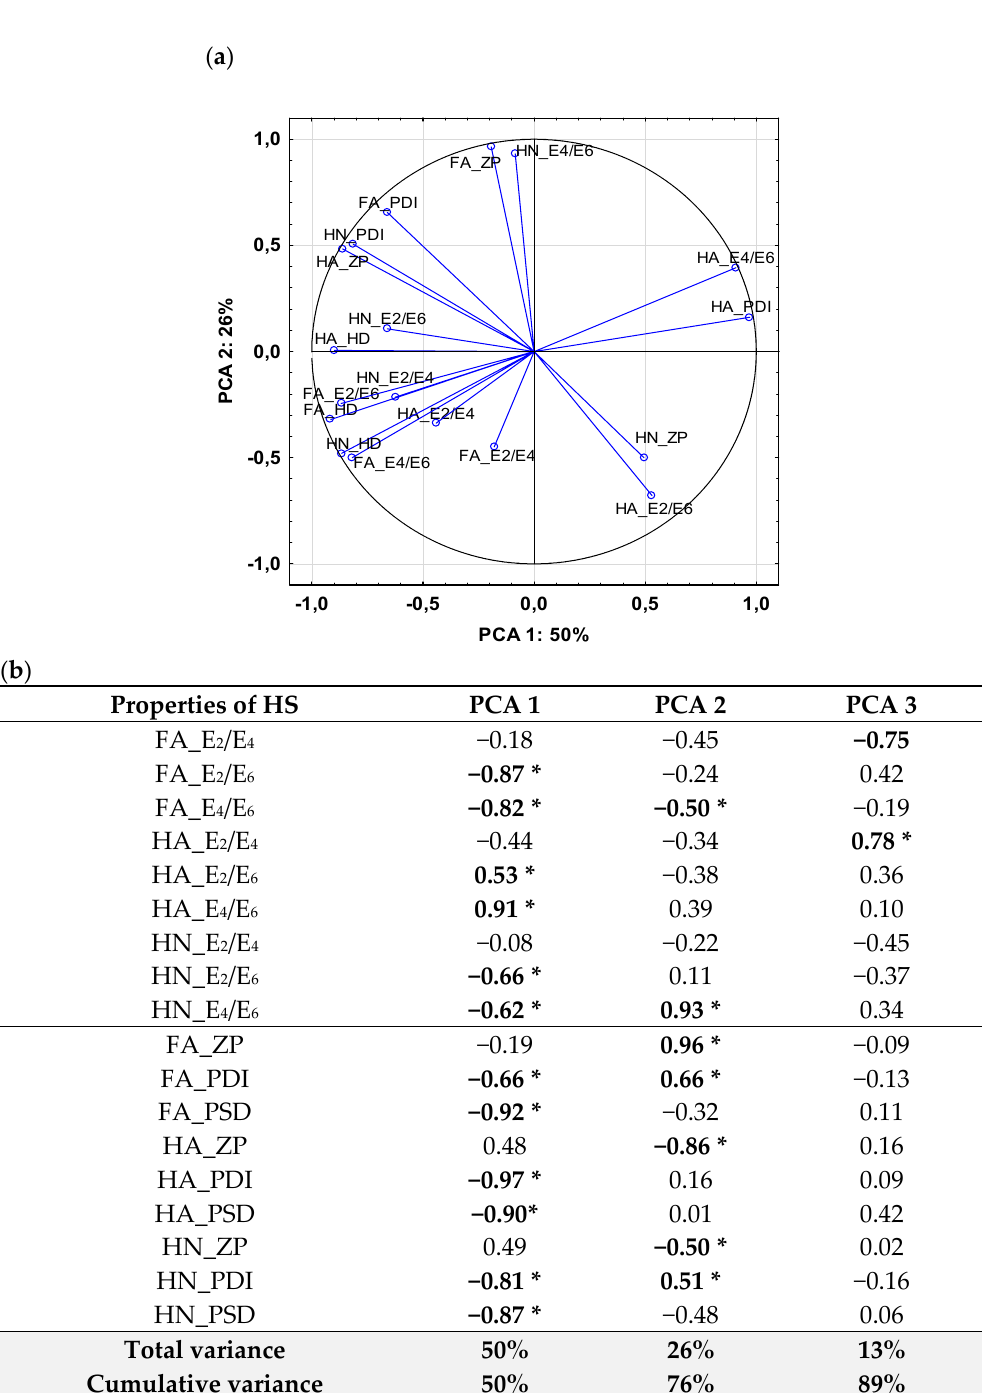
Figure 3. ( a ) Principal Component Analysis (PCA) ordination biplot (PCA 1 vs. PCA 2), eigenvectors of correlation matrix used to generate PCA components representing impact of soil type on individual properties of humic substances for all data sets (n = 30). Arrows/lines in biplot represent variable loadings relative to each component. ( b ) Factor loading matrix; loading ≥ 0.5 in bold and marked by ‘*’.